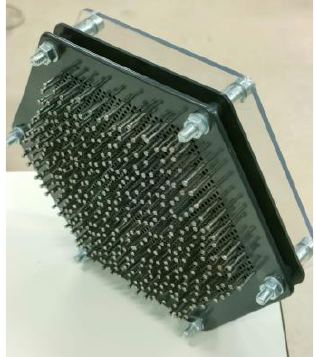
Figure 1 . Thermal speckle application tool . Figure 1. Thermal speckle application